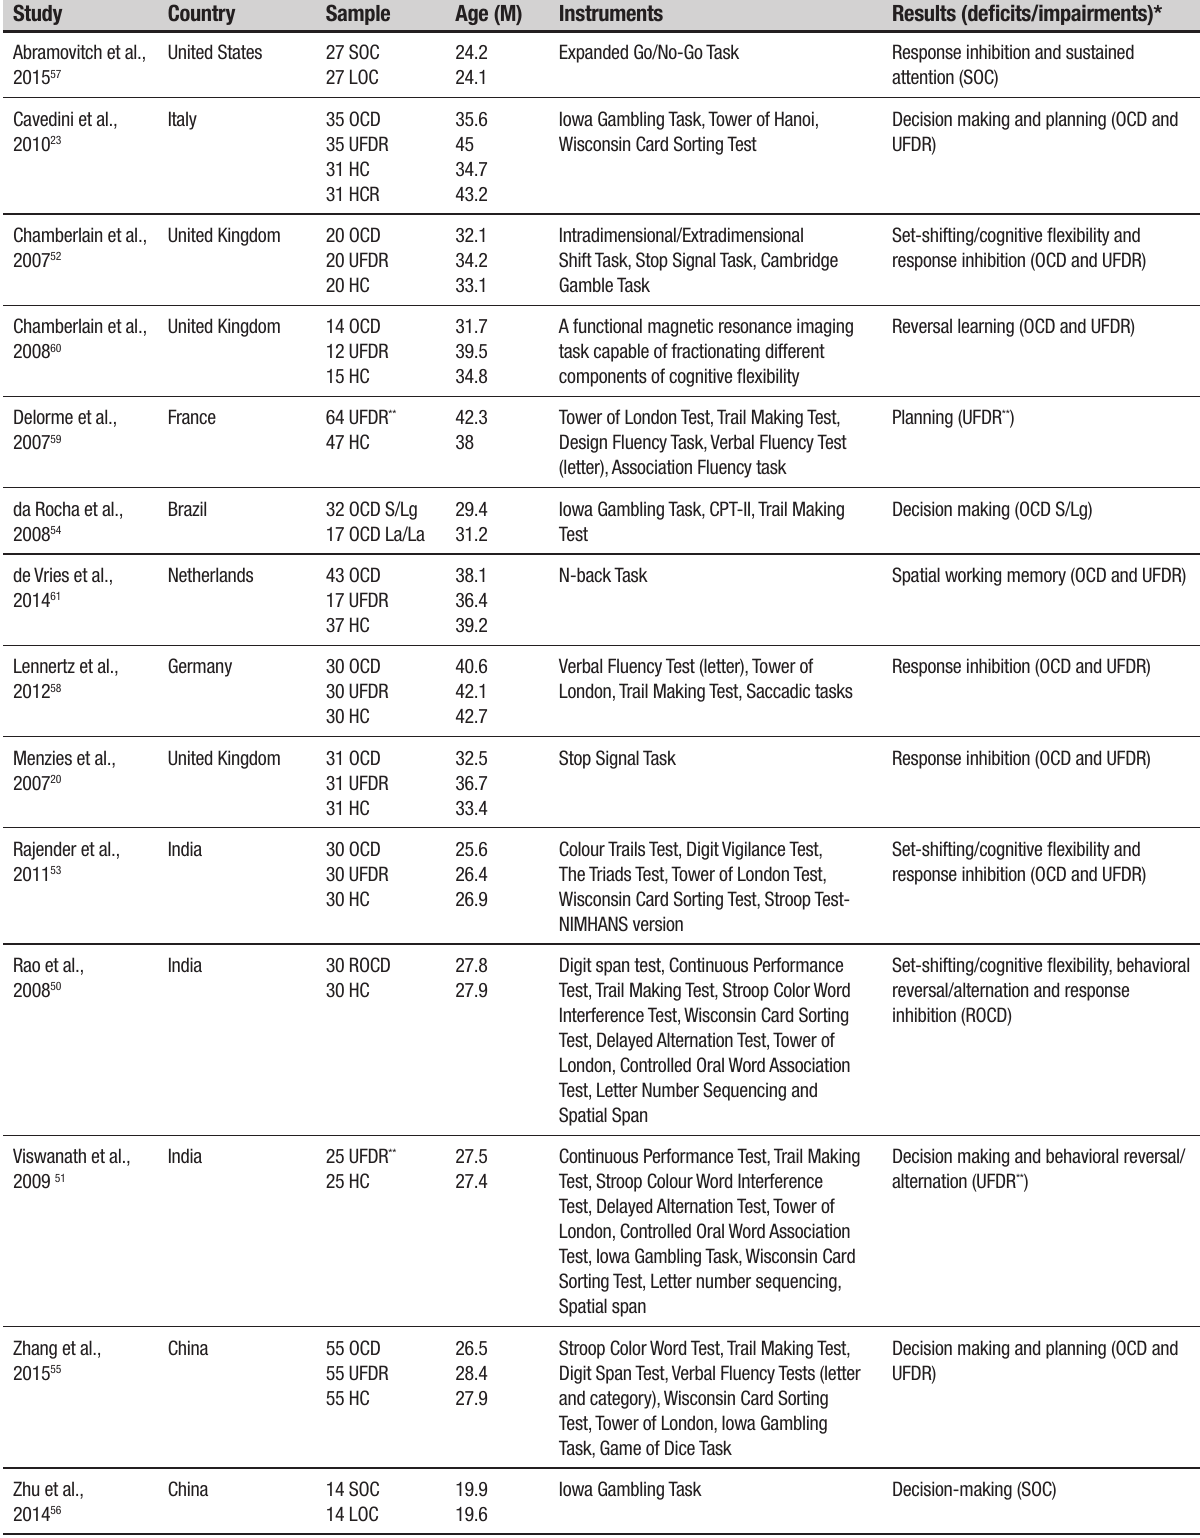
Table 1. Studies included in the review by country, sample, age (years), instruments and results.